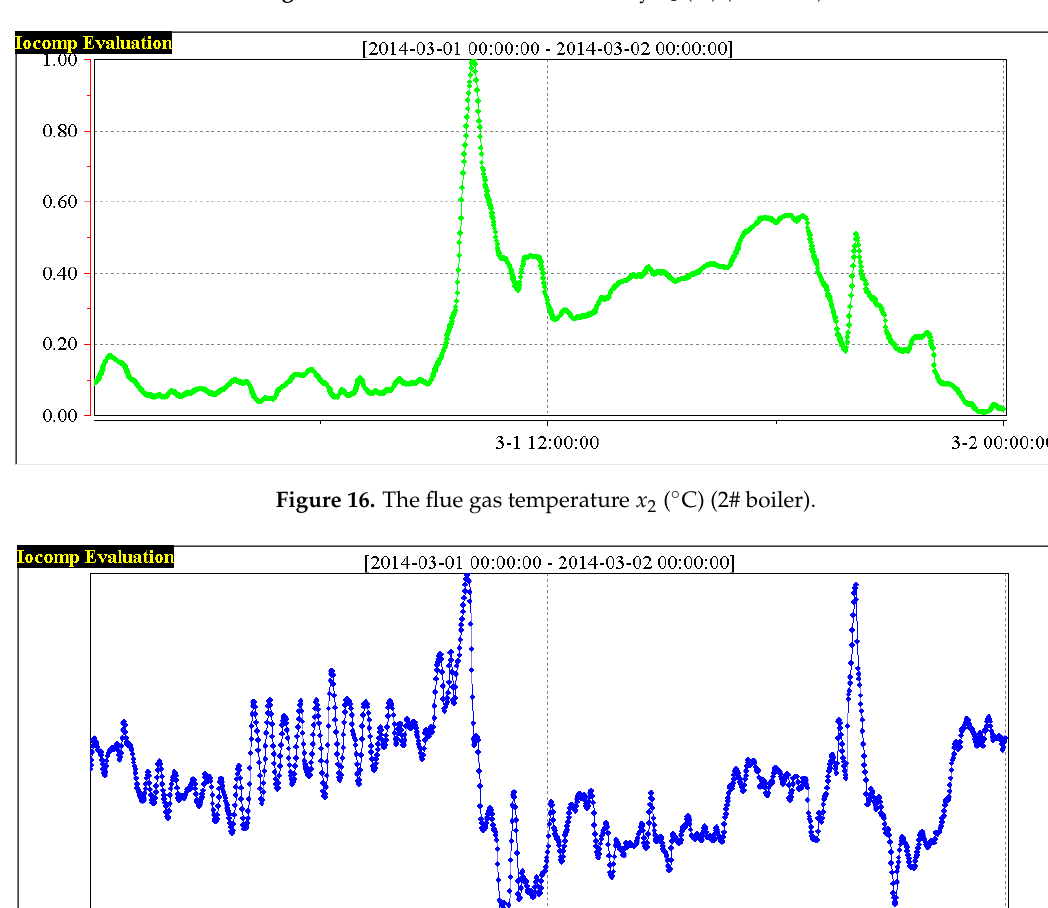
Figure 18. The carbon content of fly ash